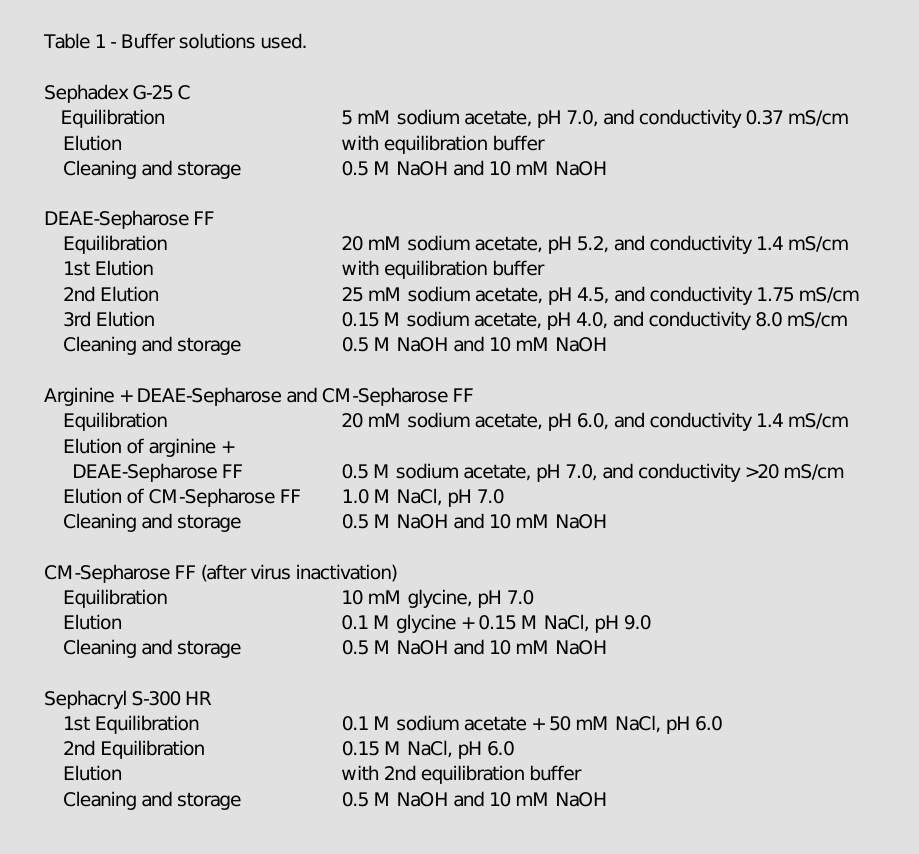
Table 1 - Buffer solutions